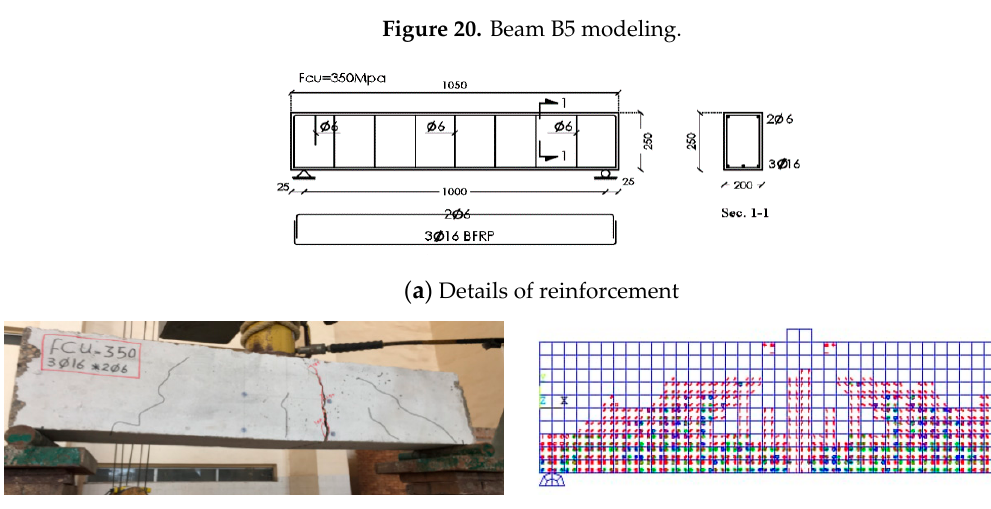
Fibers 2020 , 8 , x FOR PEER REVIEW